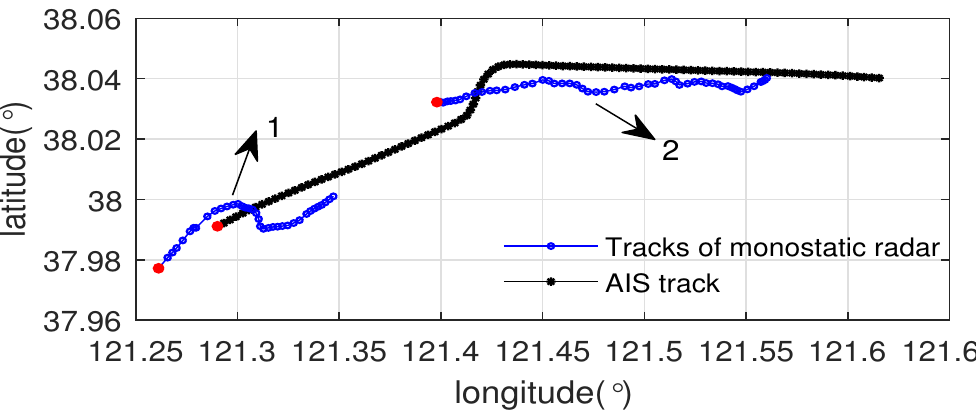
Figure 8. Track comparison between monostatic radar and AIS of target